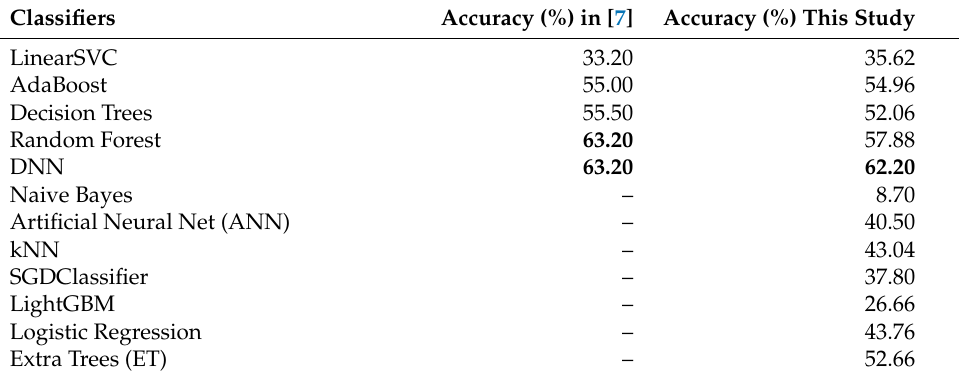
Table 1. Results comparison with the original work of [7], based on the script’s execution that the original authors published with [7]. With bold font are highlighted the optimal results of each column.